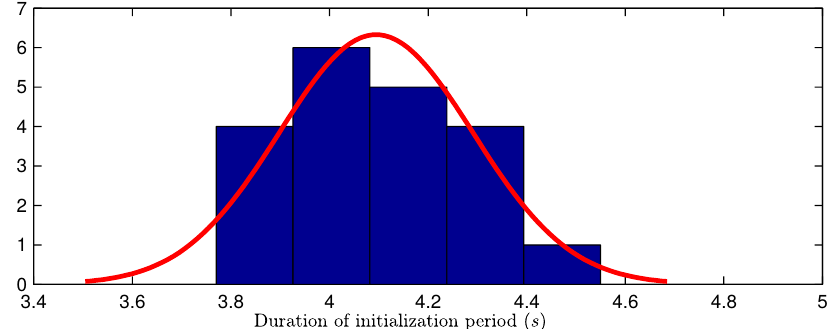
Figure 8. Histogram of the duration of the initialization period obtained after 20 runs of the proposed method. This particular case corresponds to the flight trajectory presented in Section